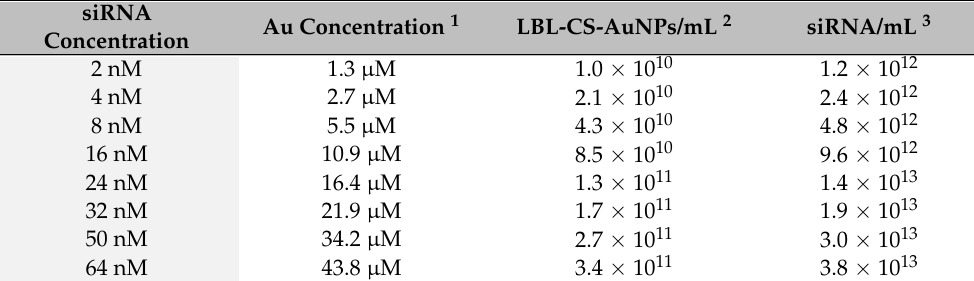
Table 2. Correlation between the effective siRNA concentration and the corresponding LBL-CS- AuNPs